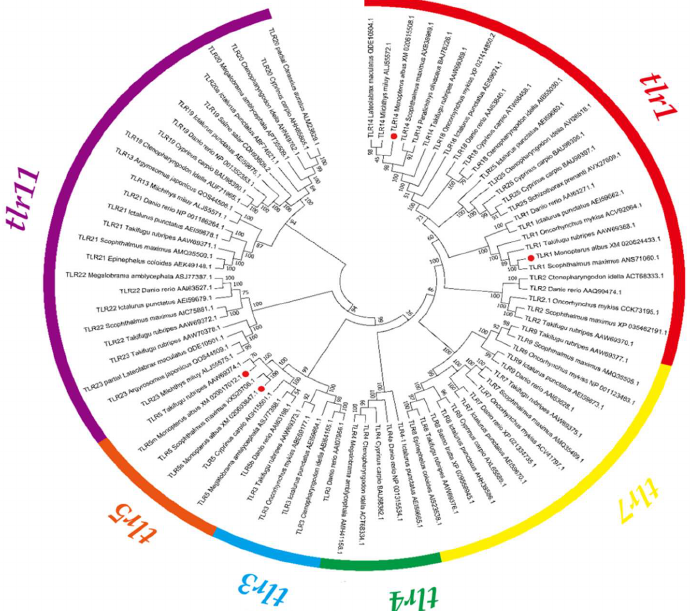
Figure 2. Phylogenetic tree of swamp eel toll like receptors (TLRs). Different subfamily proteins are represented by different colors. The species names and GenBank accession numbers are shared in the branch. A red dot represents a swamp eel TLR protein.